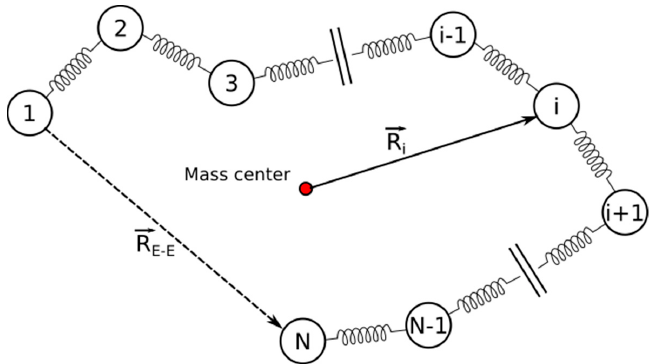
Figure 18. Rouse bead-spring polymer model.